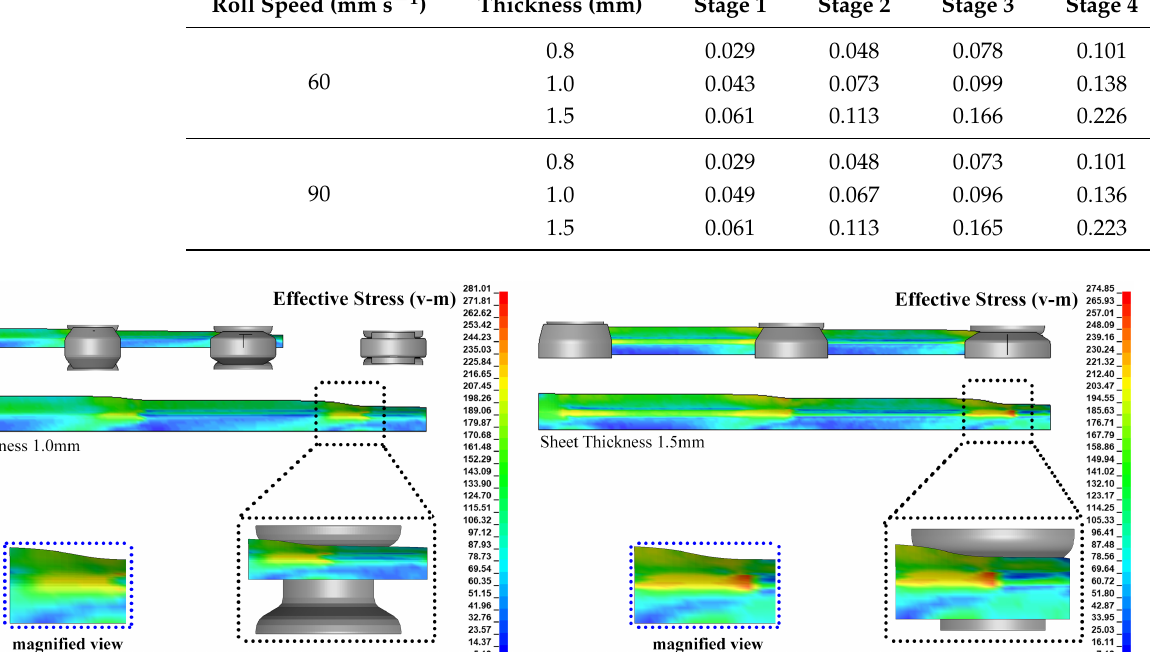
Figure 11. Effective stress contours on the formed part at roll speed of 90mms − 1